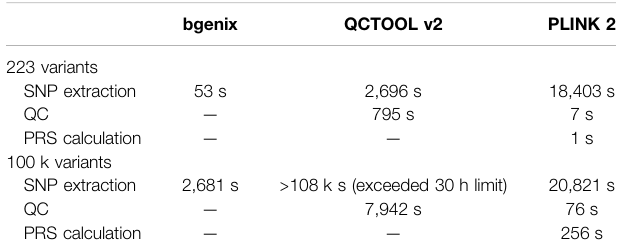
TABLE 6 | Comparison of times taken. Please note absolute times may vary dependingonthecomputationpowerofthesystemused,ourinterestisinthe relative performance of the